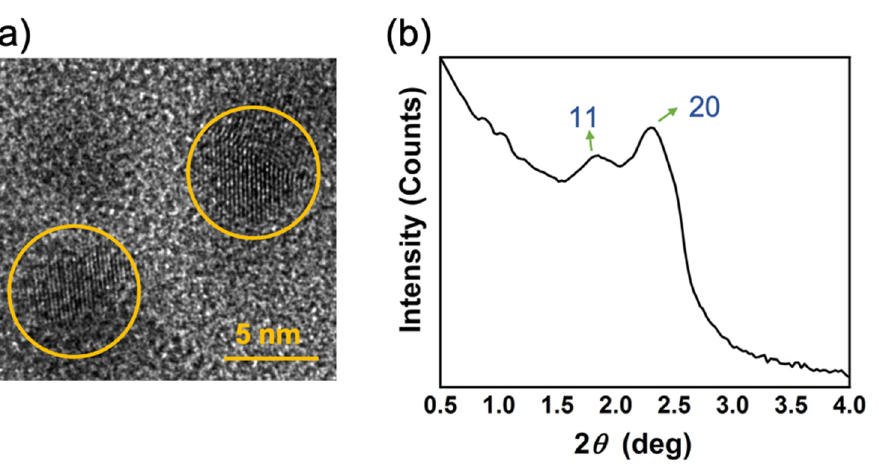
Figure 2. Structural analysis of the CH 3 NH 3 PbBr 3 perovskite and mesoporous silica. ( a ) A TEM pho- tograph of perovskite embedding in mesopores, with the perovskite quantum dots marked dis-